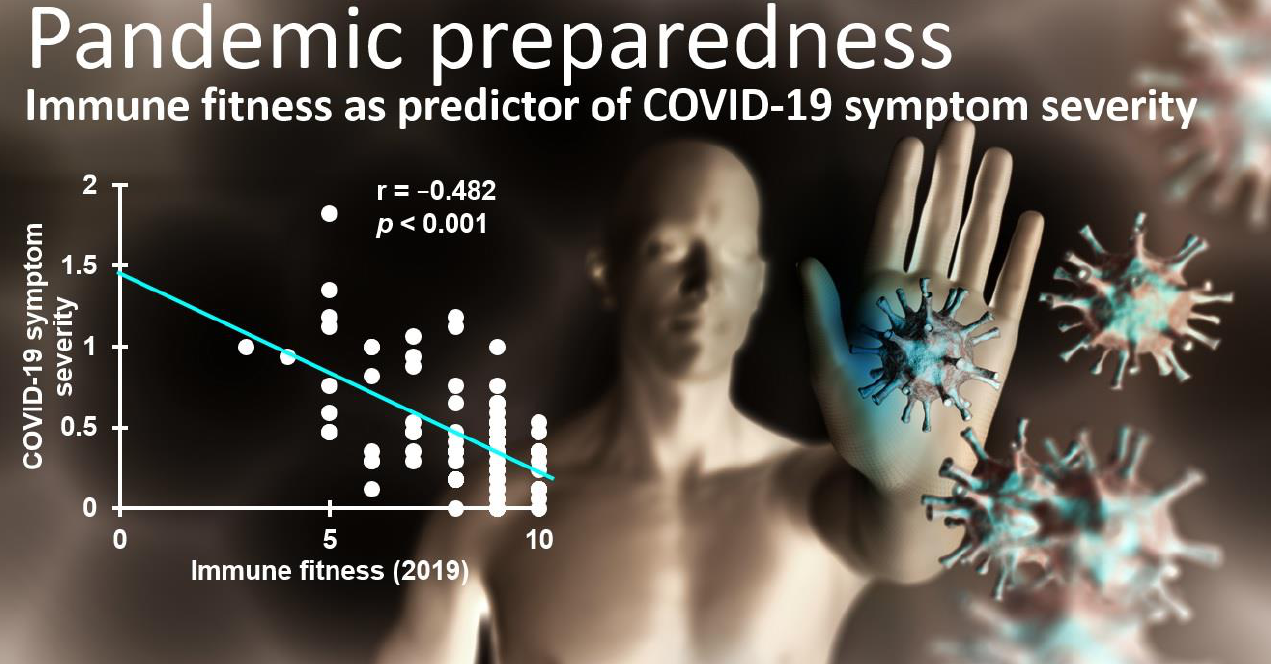
Figure 3. Relationship between immune fitness and the severity of COVID-19 symptoms. Immune fitness was assessed for 2019 with the Immune Status Questionnaire (ISQ) [17]. COVID-19 symptom severity was assessed in 2020–2021 in n = 87 subjects with confirmed infection with SARS-CoV-2. Data from reference [19]. Permission to use the background image was obtained from Depositphotos.